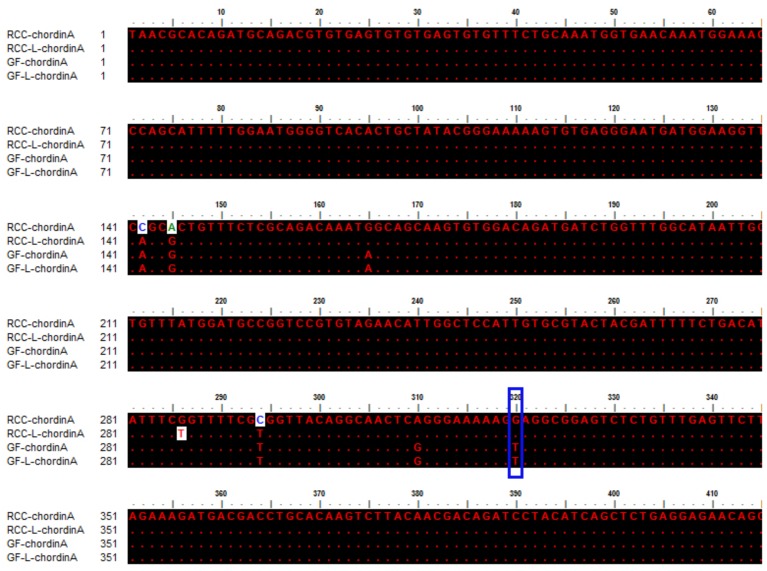
Sequence comparison of chordinA in RCC, RCC-L, GF-L, and GF. The blue box represents the mutation base regarding the formation of twin tails. The dots represent the same base.